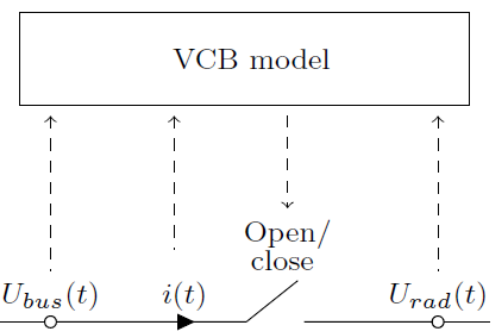
Figure 6. Schematic of the VCB